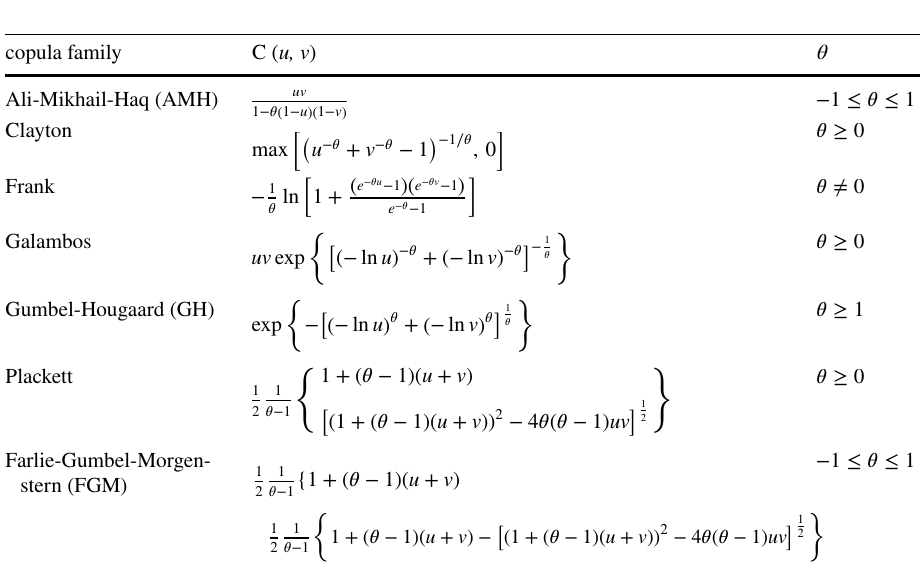
Table 2 The copula functions used in present research work